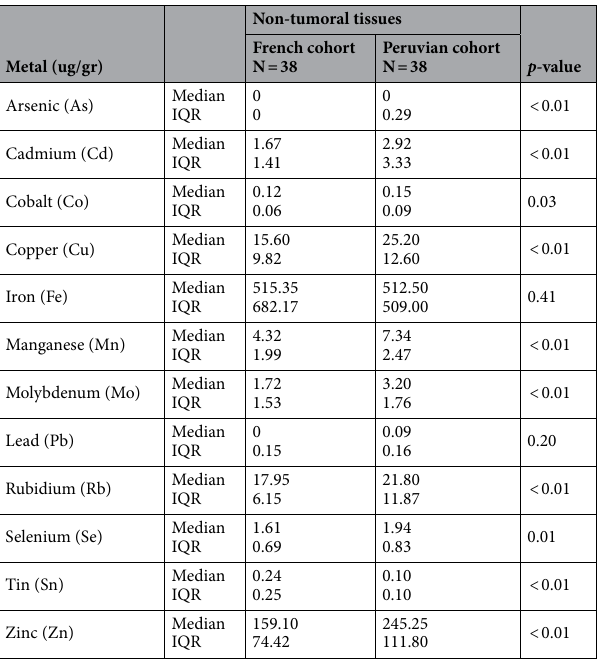
Table 2. Metal quantification in non-tumoral tissues from patients in both cohorts. Data are presented as median and interquartile range (IQR). Levels of significance ( p < 0.05) were calculated with Mann Whitney U-test.